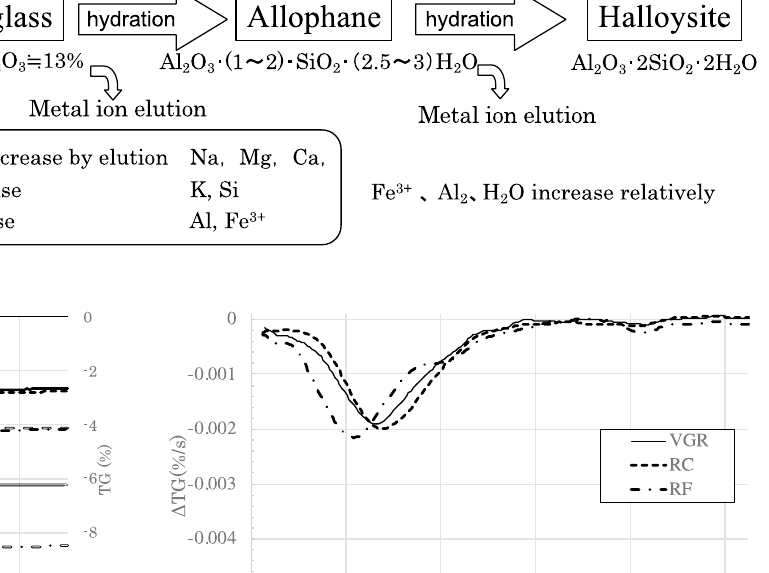
Fig. 9 Weathering sequence of VG